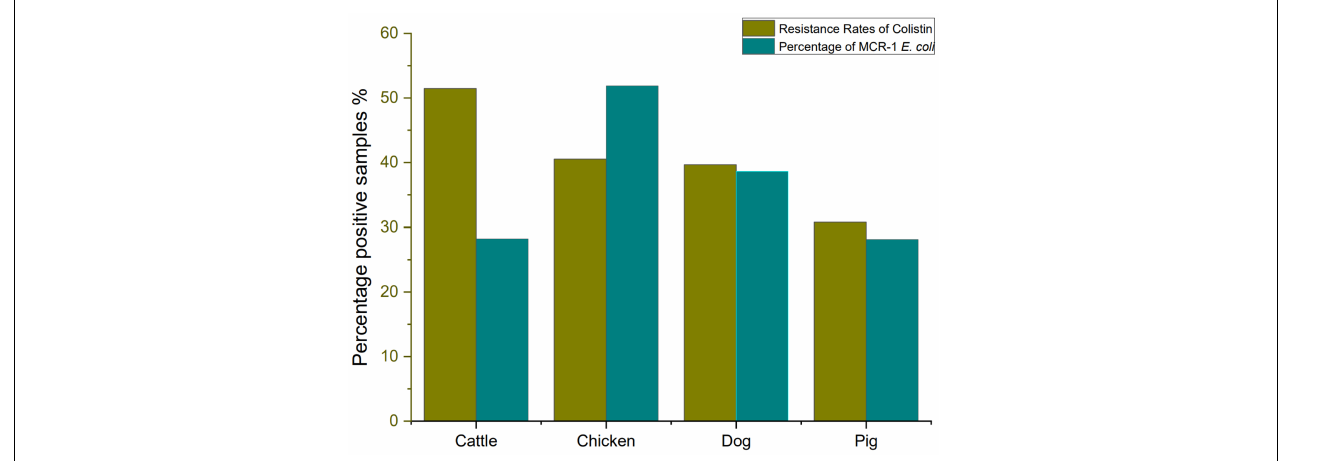
FIGURE 1 | The resistance rate to colistin and percentage of mcr-1 –positive Escherichia coli.